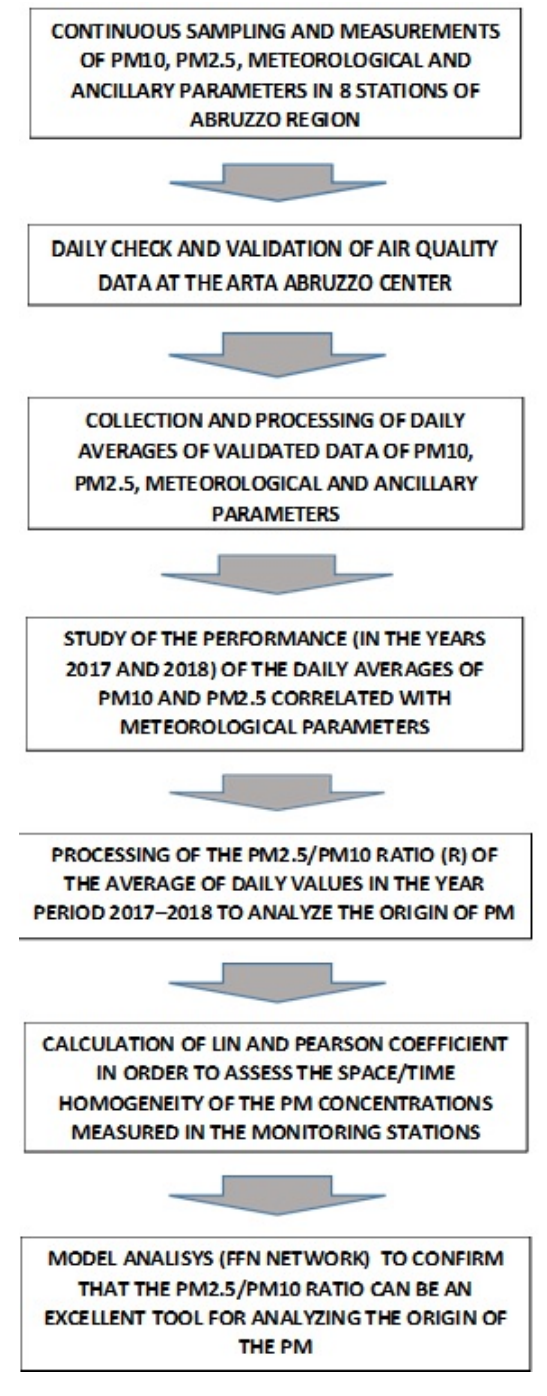
Figure 1. Flowchart of the study steps.